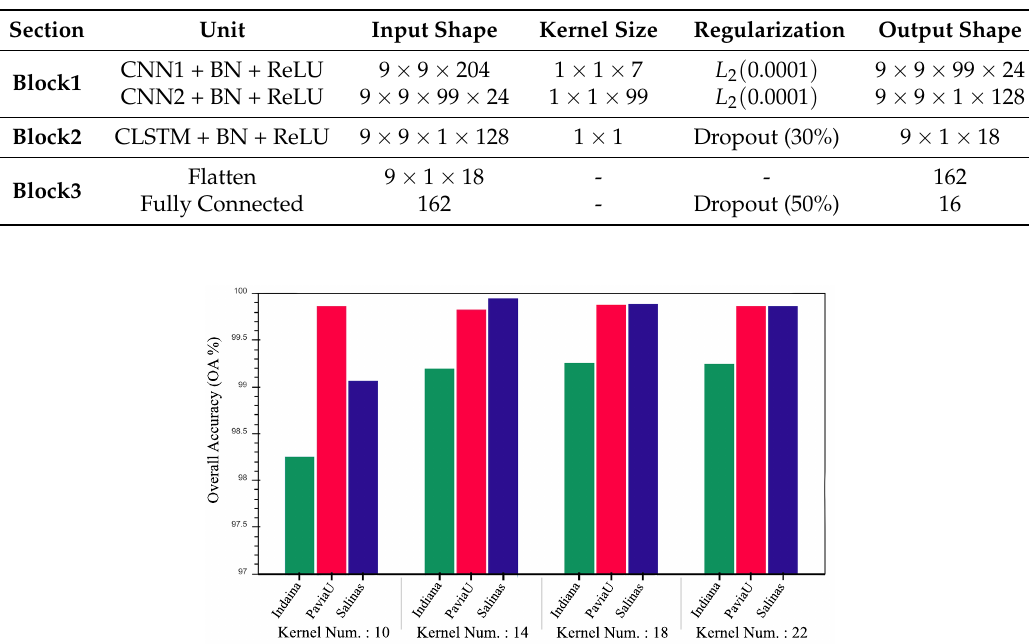
Figure 6. The overall accuracy (OA) of the PRCLSTM with different numbers of kernels for Block